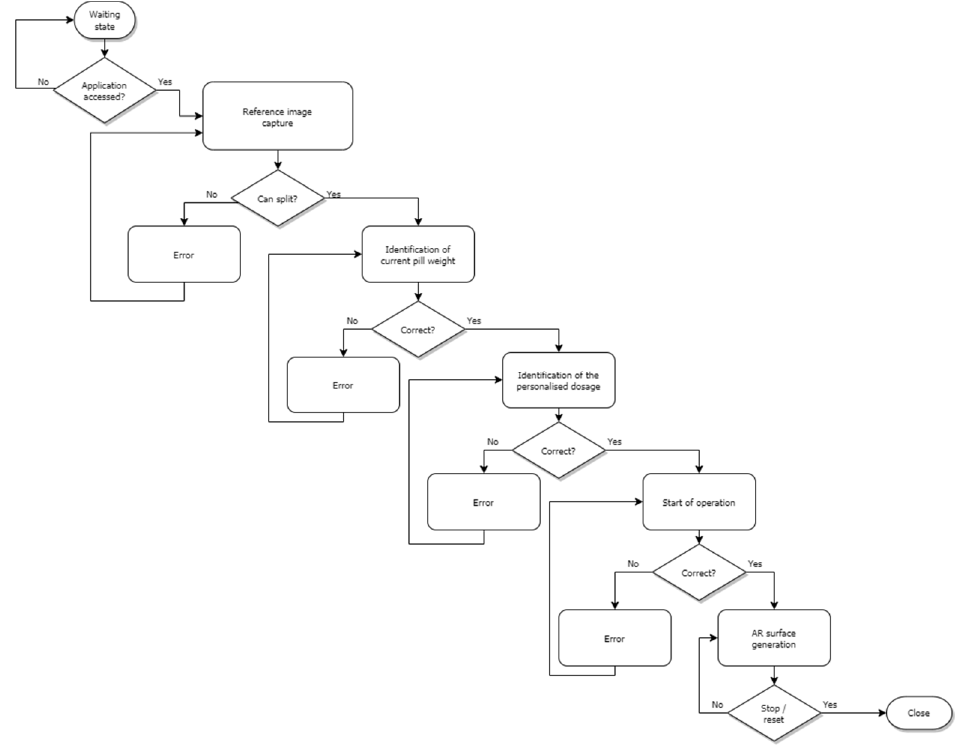
Figure 3. Block diagram of the application.